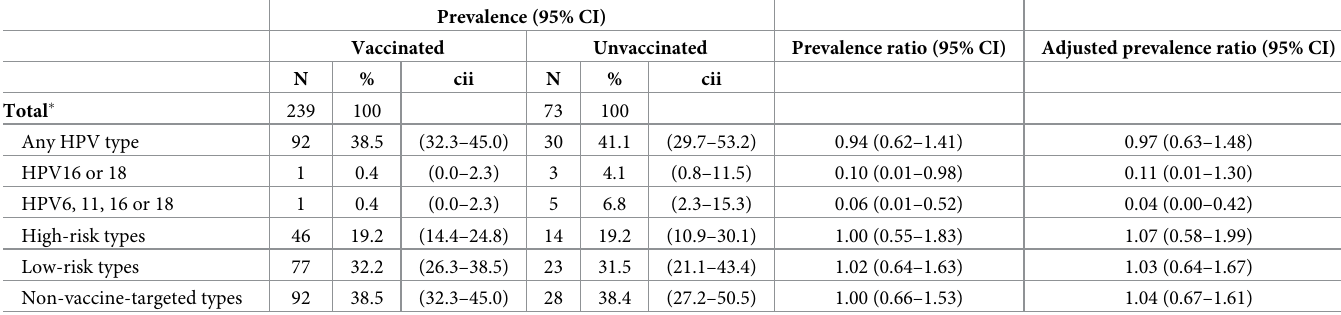
Table 2. Type-specific prevalence of human papillomavirus (HPV) in vaginal samples by HPV vaccination